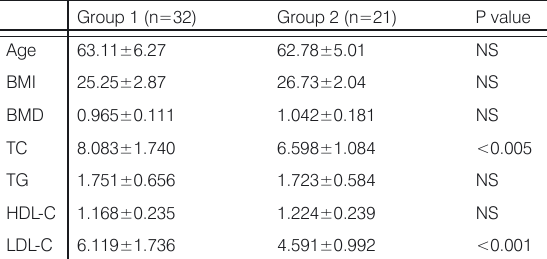
Parameter values at the beginning of the study were evaluated as described in the Materials and Methods section. All results were presented as mean±SD. Levels of TC, TG, HDL-C and LDL-C were given in mmol/l. Abbreviations: BMI = body mass index, BMD = bone mineral density, TC = total cholesterol, TG = total triglycerides, HDL-C = cholesterol in high density